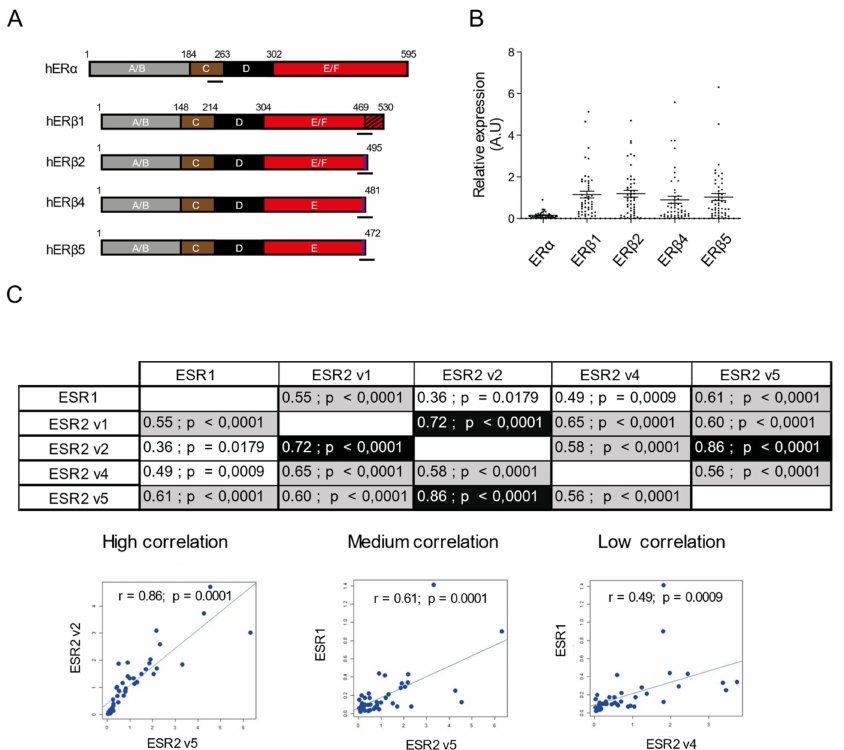
Figure 1. ER β isoform mRNAs are highly expressed in hGCs with positive correlations between pairs of ER β isoforms. ( A ) Schematic representation of ovarian human ER α and ER β (hER). The A/B domain at the NH2 terminus contains the AF-1 site, where other transcription factors interact. The C/D domain (brown/black boxes) contains the two-zinc finger structure that binds to DNA, and the E/F domain (red box) contains the ligand binding pocket as well as the AF-2 domain, which directly contacts coactivator peptides. ER β spliced isoforms are formed from alternative splicing of the last coding exon (shown by the striped bar); ER β isoforms are identical in their first 468 amino acids but differ in the sequence corresponding to the end of the ligand binding of ER β 1. Approximate locations of the primers used for qPCR are indicated. ( B ) hGCs were cultured for 24 h before RNA extraction. Relative levels of ER α ( ESR1 ) and ER β 1 ( ESR2 v1), ER β 2 ( ESR2 v2), ER β 4 ( ESR2 v4), and ER β 5 ( ESR2 v5) isoforms mRNAs were determined by RT-qPCR analysis for each patient ( n = 49). Transcript levels were normalized to GAPDH transcripts abundance. Values are represented as means ± SEM from two or three identical wells per patient, measured in triplicate. ( C ) We evaluated the correlations between relative mRNAs levels of each pair of genes. Data are represented in the table; correlation values are categorized as “high” r > 0.65 (black highlighted), “medium” r between 0.5 and 0.65 (grey highlighted), and “low” r < 0.5. An example of the relationship between mRNA abundances for each category is represented by the fitted (log) blue line (—-). Significance values from Pearson correlations are given on the